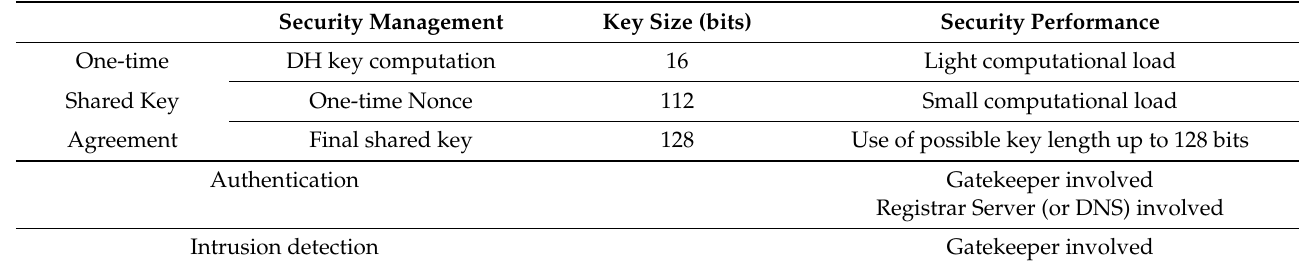
Table 3. Security